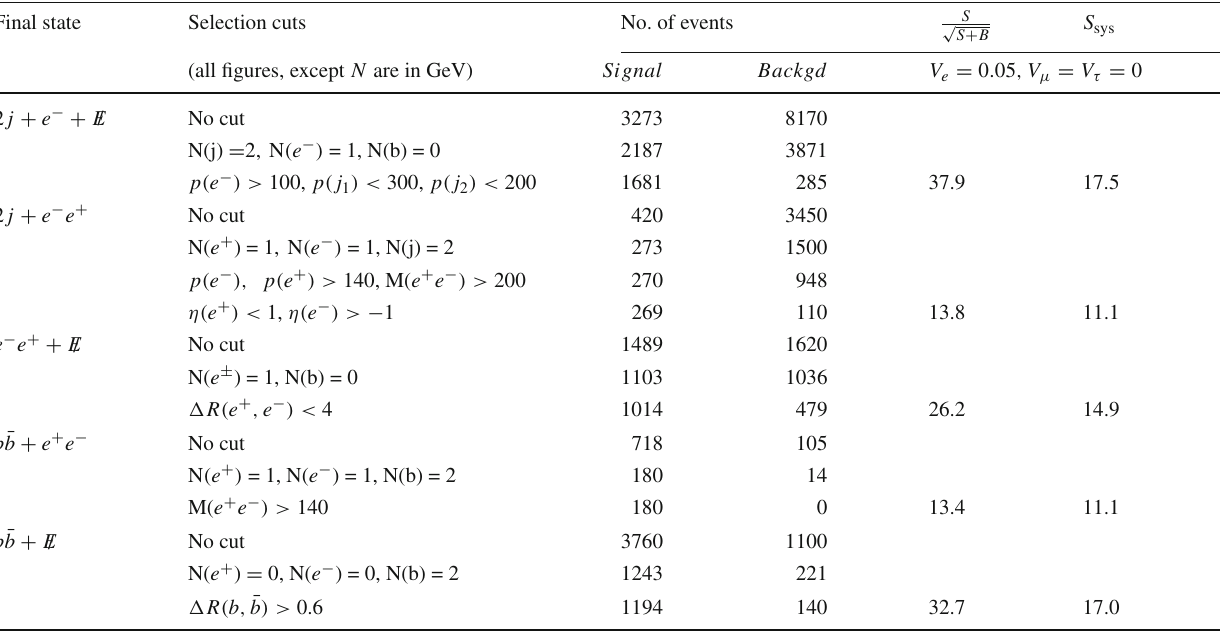
Table 4 The cut-flow and signal significance for different final states arising from the single production of (cid:2) 0 and (cid:2) ± at fb − 1 luminosity for processes e − e + → (cid:2) ± (cid:4) ∓ and e + e − → (cid:2) 0 ν , with M (cid:2) = 500 GeV and V e = 0 . 05 , V μ = V τ =